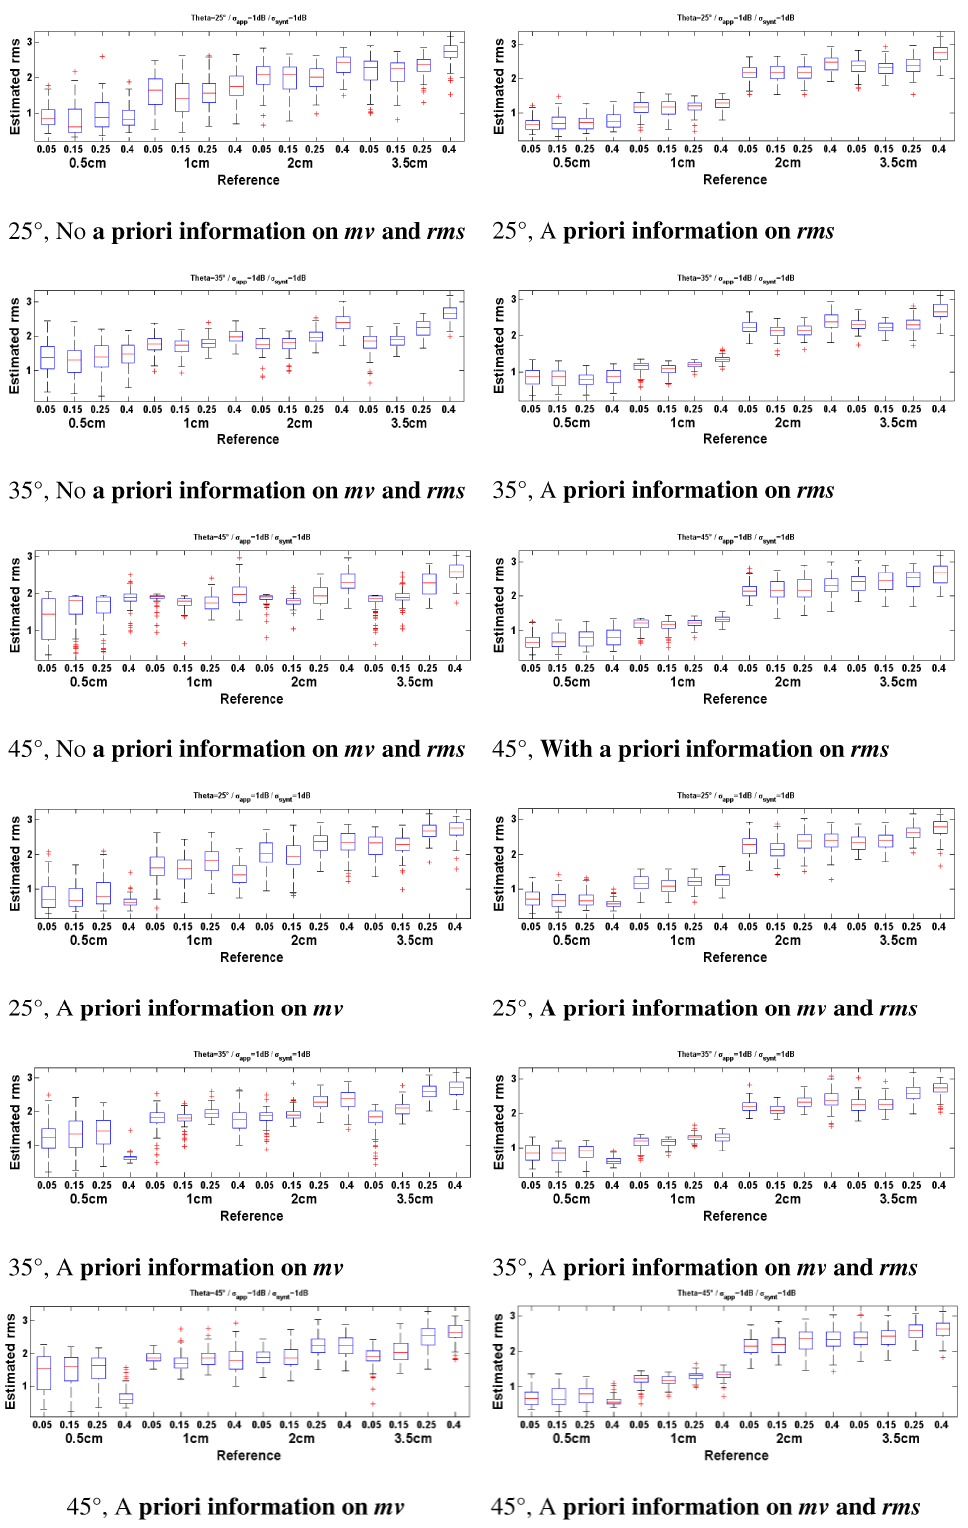
Fig. 3. Box plots of surface roughness estimates (cm) from the synthetic dataset. Training and validation datasets correspond to a noise on the backscattering coefficients of ± 1dB. Four rms and four mv values were plotted: rms=0.5, 1, 2, 3.5 cm; mv=0.05, 0.15, 0.25, 0.40cm 3 cm − 3